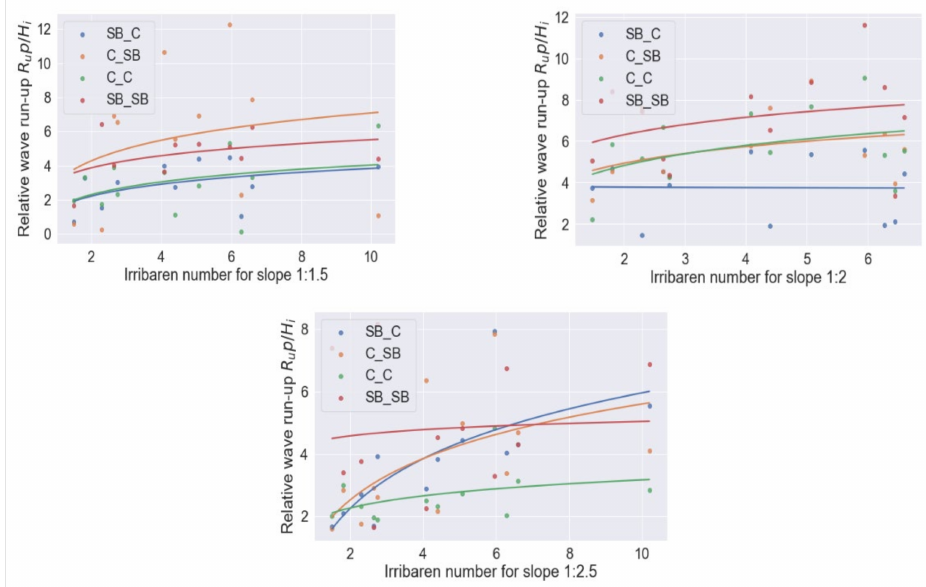
Figure 19. Relative wave R up /Hi for the three slopes.